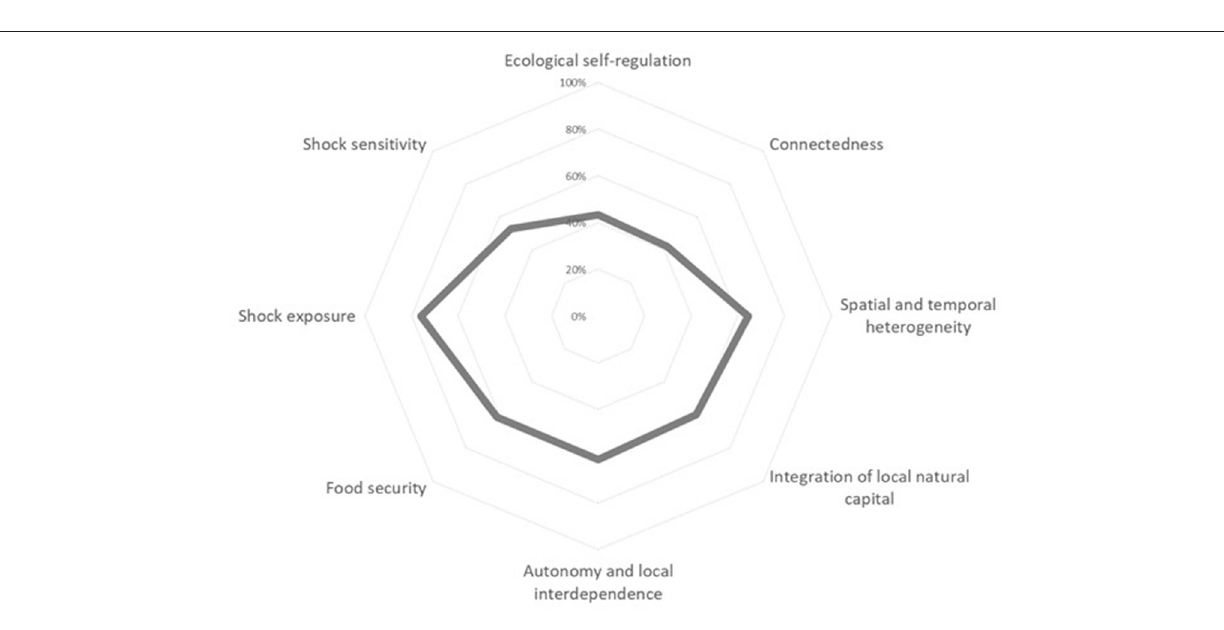
FIGURE 6 | Overall assessment of the perceived resilience of the participating farms ( n = 53) based on Cabell and Oelofse (2012) framework and additional food system resilience parameters (Ericksen et al., 2012; Intergovernmental Panel on Climate Change, 2014), 100% represents the highest